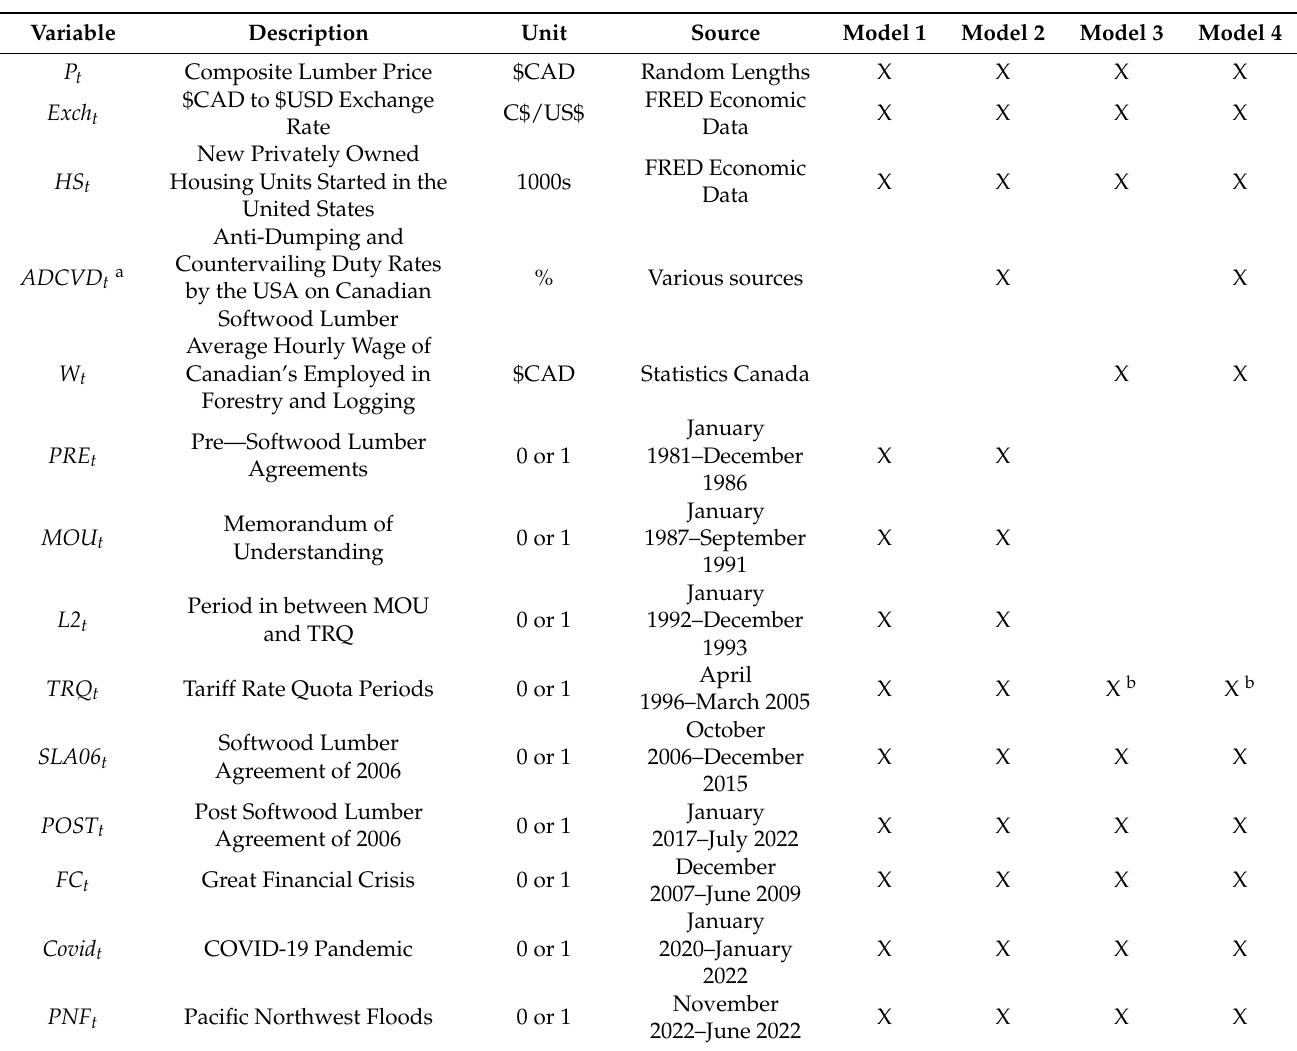
Table 3. 1981–2022 variables, their descriptions, and